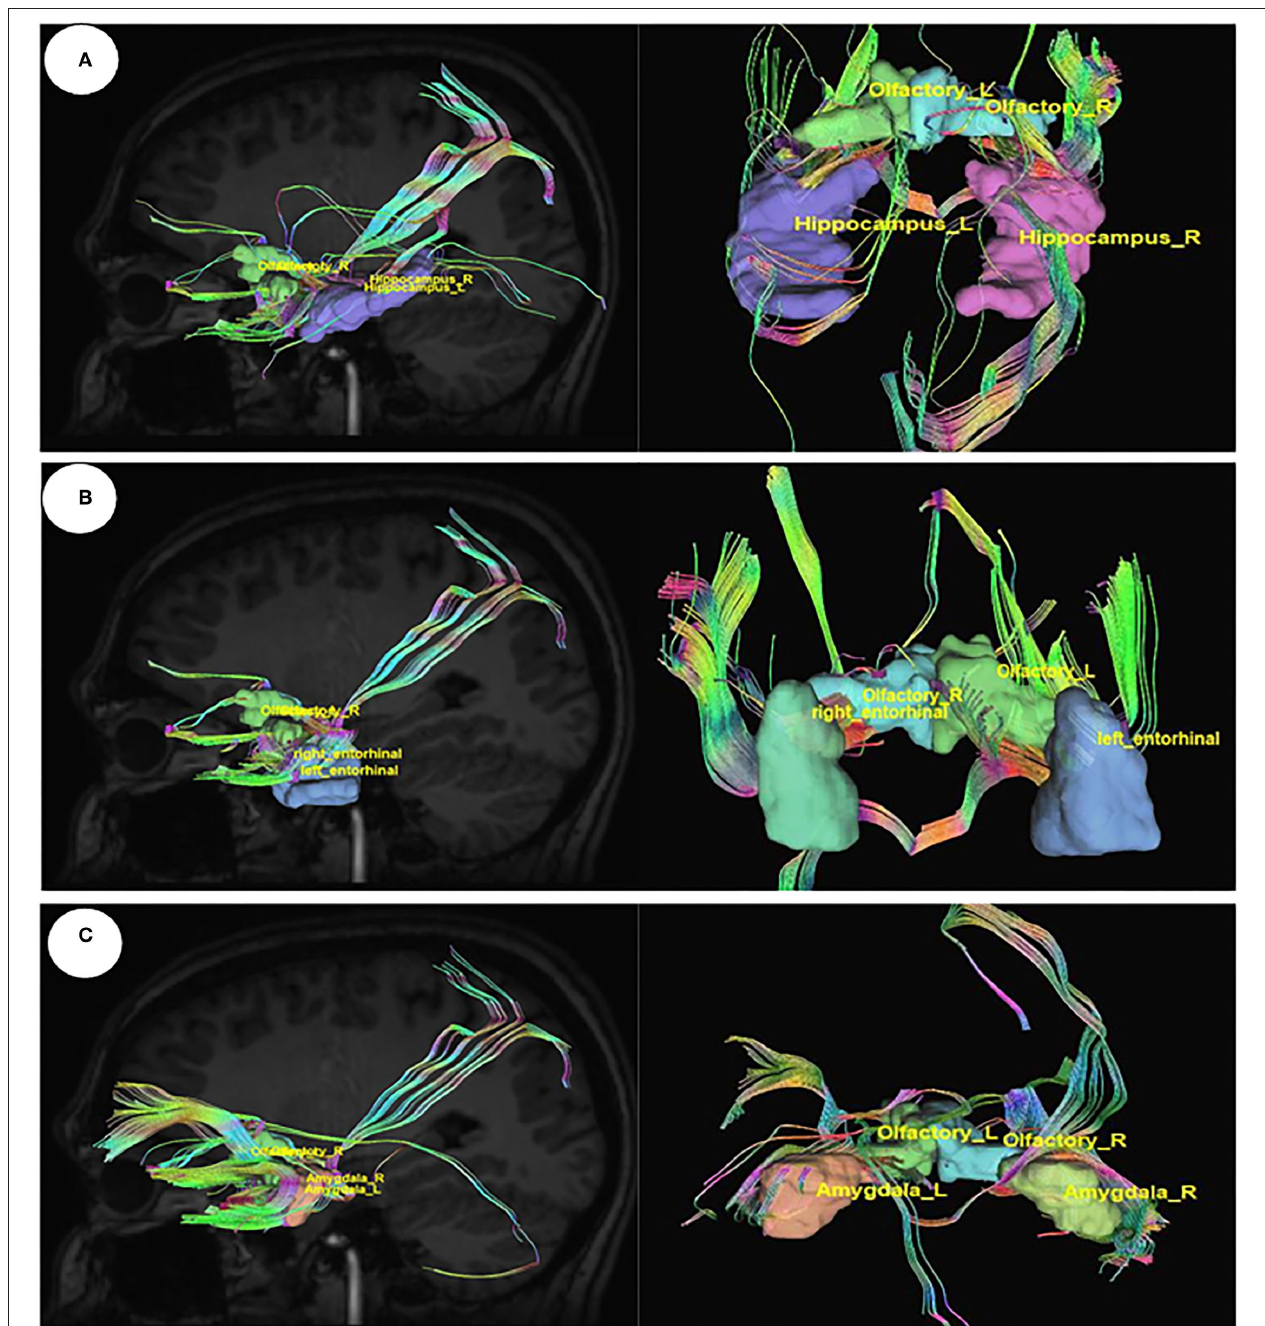
FIGURE 5 | Diffusion MRI fiber tracking connecting the olfactory nerve with (A) the hippocampus, (B) the entorhinal cortex, and (C) the amygdale.